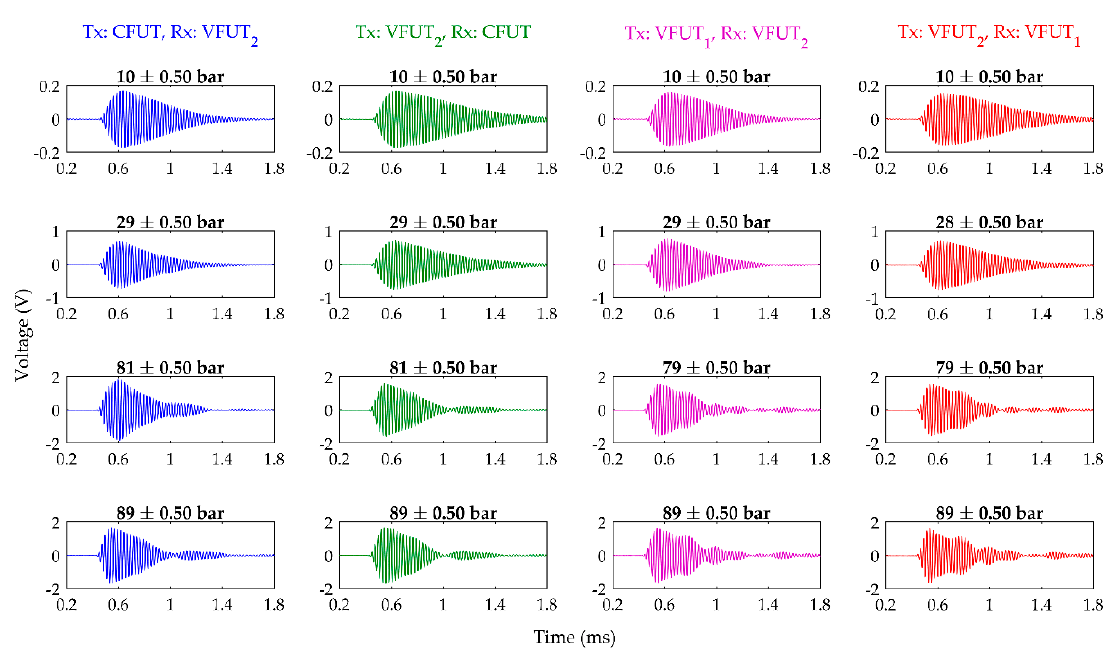
Figure 7. A-scans for increasing levels of air pressure inside the pressure chamber utilizing different combinations of T X and R X transducers.